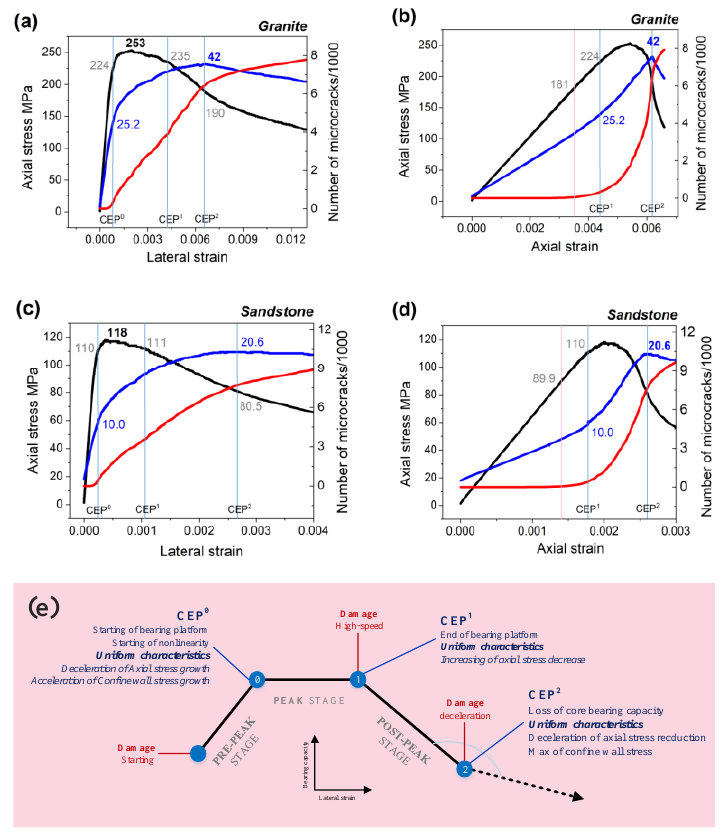
Figure 7. Data curve and its characteristic points. ( a ) ; ( b ) ; ( c ) ; ( d ) ; ( e ) .